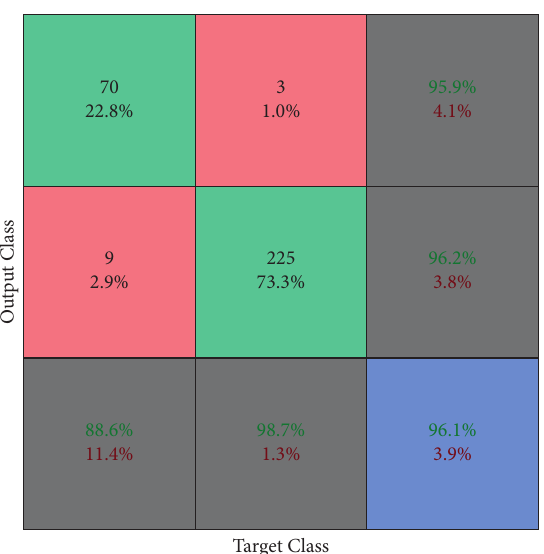
Figure 14: Confusion matrix plot of proposed plant leaf detection using random forest classifier.